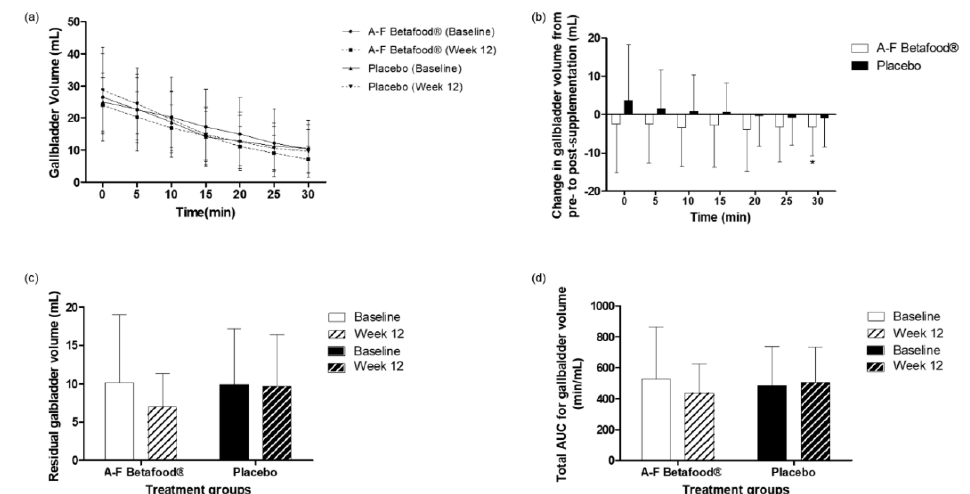
Figure 3. Ultrasound gallbladder volume assessments in the per protocol population at baseline and week 12 post-supplementation with A-F Betafood ® or placebo (n = 42). ( a ) Mean gallbladder volume and ( b ) mean change in gallbladder volume measured at five-min intervals, ( c ) mean residual gallbladder volume and ( d ) total AUC for gallbladder volumes. Mean ± SD, where * p < 0.05. AUC, area under the curve.